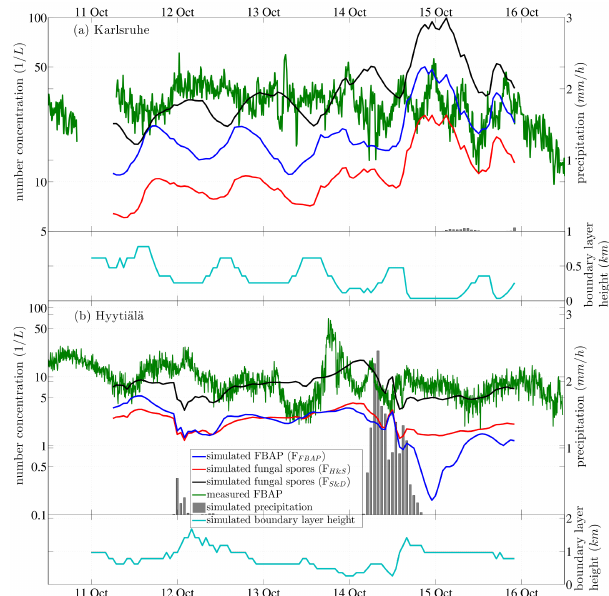
Figure 3. Time series of measured FBAP and simulated fungal spore/FBAP number concentrations in 1L − 1 together with simu- lated precipitation in mmh − 1 (right axis) and simulated boundary layer height in kilometers (right axis) during the case study from 22 July to 28 July 2010 at (a) Karlsruhe, Germany, and (b) Hyytiälä, Finland. Simulations were performed with three different emission parameterizations: F H&S from Heald and Spracklen (2009), F S&D from Sesartic and Dallafior (2011), and F FBAP from this study.